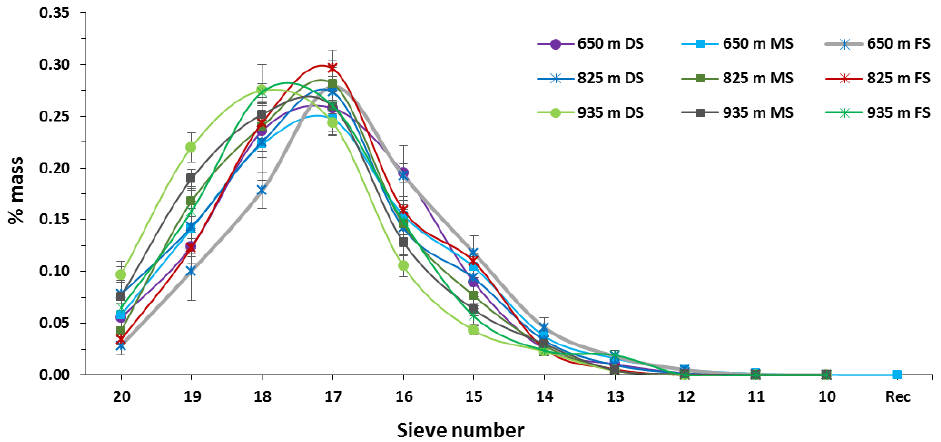
Figure 3. Distribution of green coffee beans according to their size, obtained under three light exposure conditions (deep shade, DS; moderate shade, MS; full Sun, FS), and three altitudes (650 m, 825 m and 935 m). Values represent the values ± SE (n = 5).